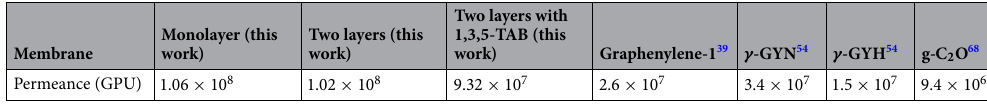
Table 4. H 2 permeance of the GDY-H membrane in our approach and other proposed membranes at room temperature (300